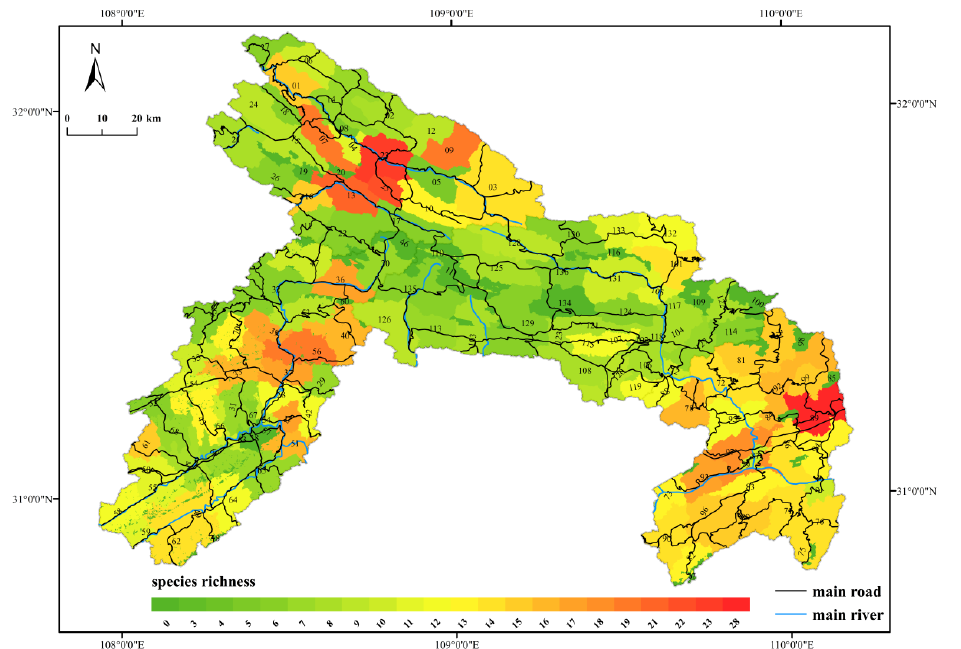
Figure 8. Distribution map of IAS. (Map serial number correspondence table is provided in Supplementary File S2).